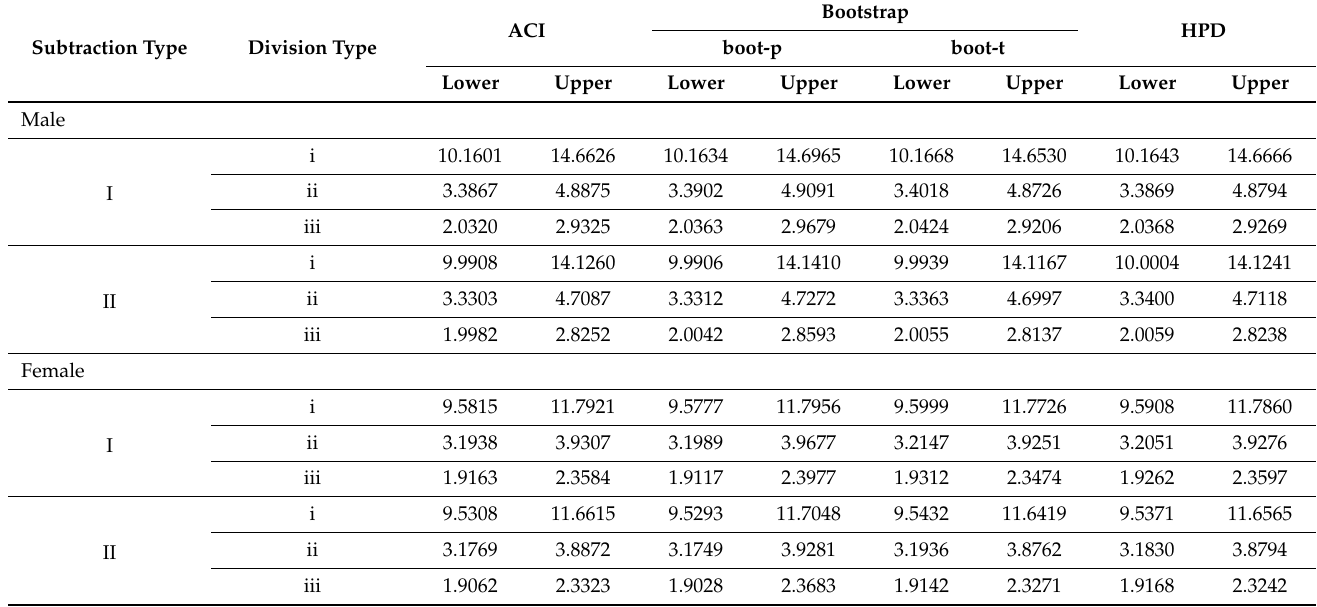
Table A10. The results of four intervals for σ at 90% confidence/credible level.